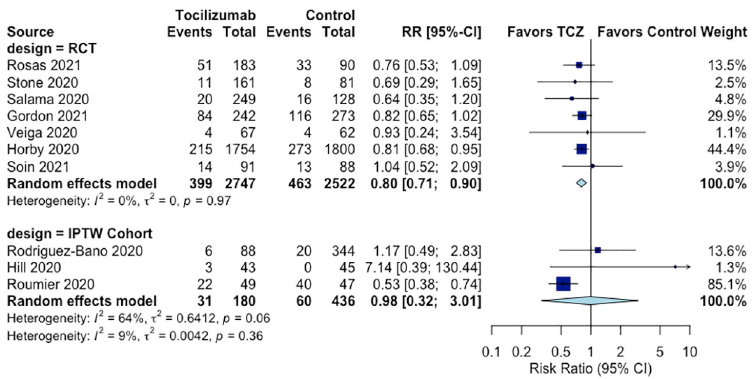
Fig 3. Effect of tocilizumab on mechanical ventilation in RCTs and IPTW cohorts of hospitalized COVID-19 patients.